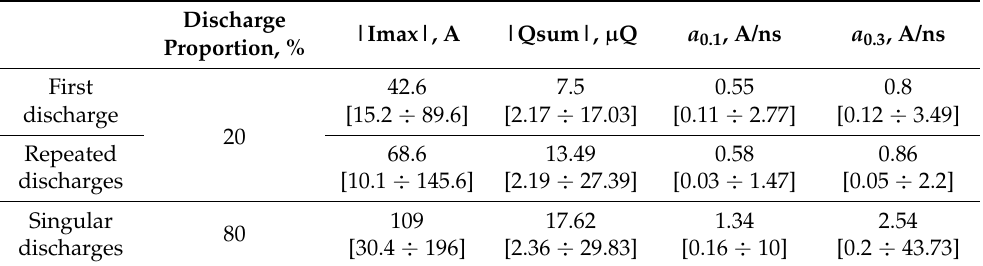
Table 4. Parameters of main stage discharge current pulses from the system of artificial thunderstorm cells of positive polarity involving two groups of model hydrometeors (mean value,